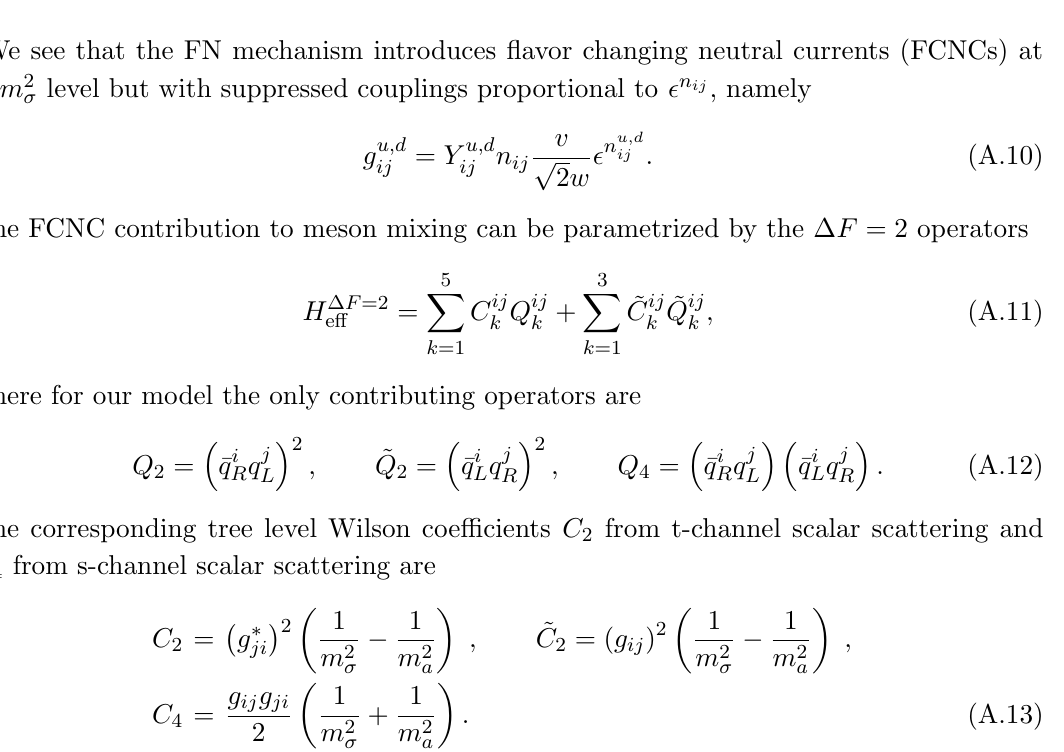
Table 1 . List of used values for the Wilson coe(cid:14)cients (in units 1 = GeV 2 ) [26, 27]. We only use absolute values of the Wilson coe(cid:14)cients. For the Kaon system generalized bounds exist depending on the sign of the contribution which would slightly improve the